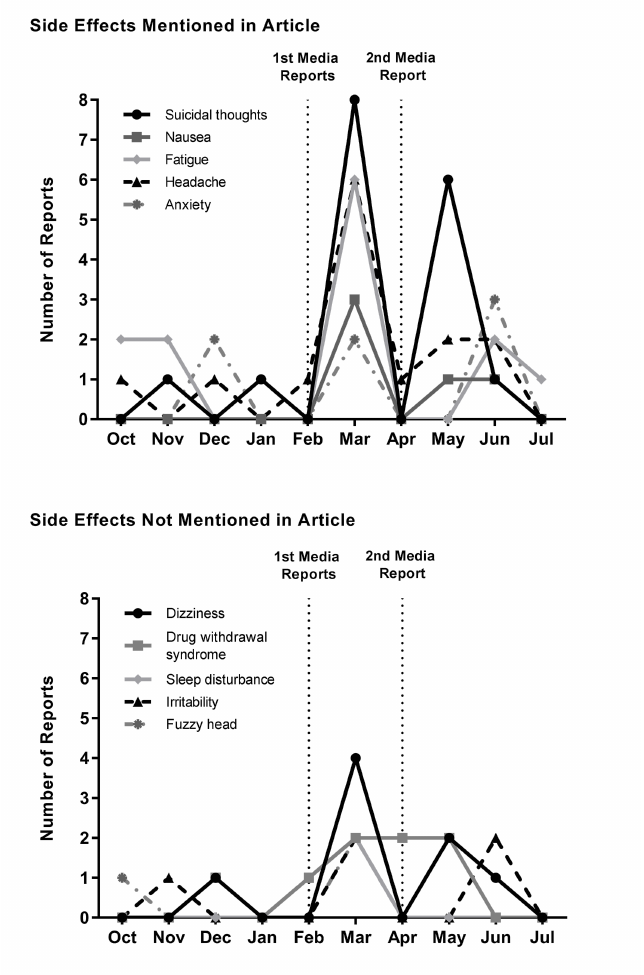
Figure 2. Numbers before and after media reports for the specific side effects reported in the media and control symptoms not in media